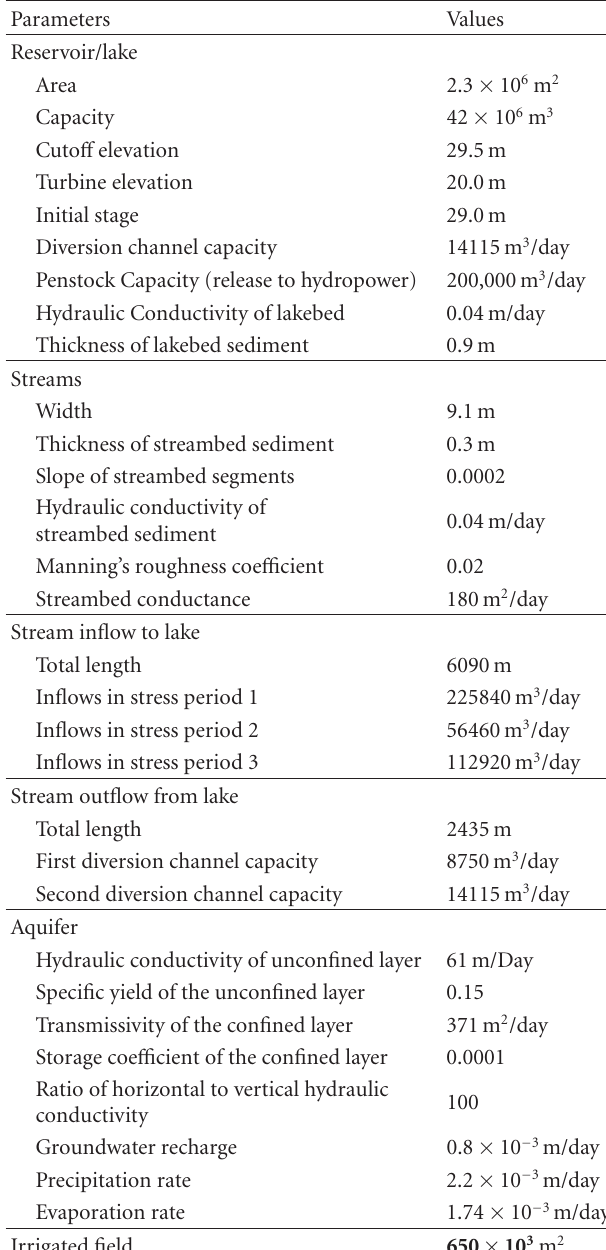
Table 1: Parameters associated with the streams, lake, and